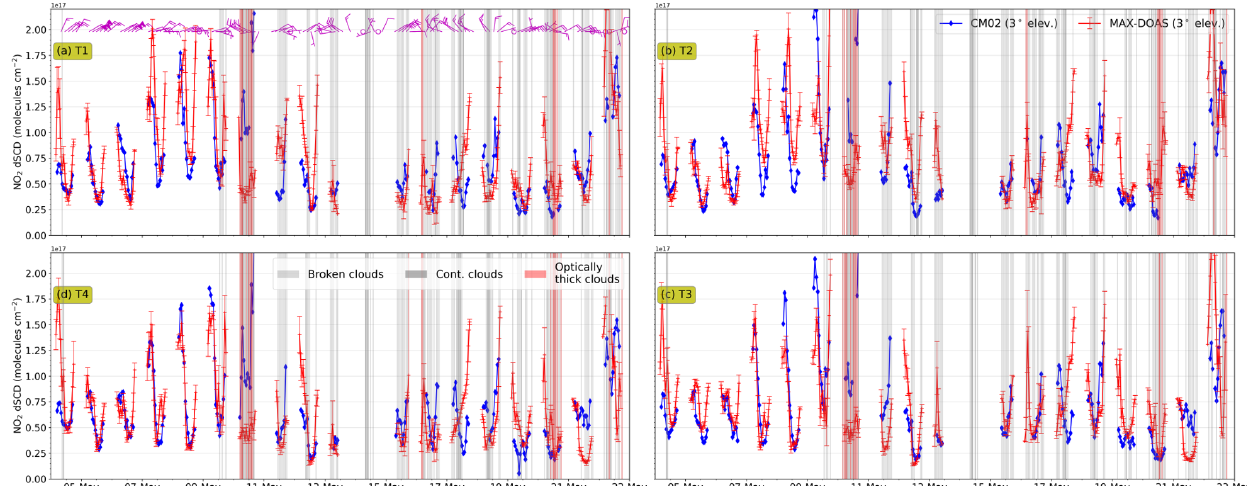
Figure 11. Same as Fig. 9 but for 3 ◦ elevation